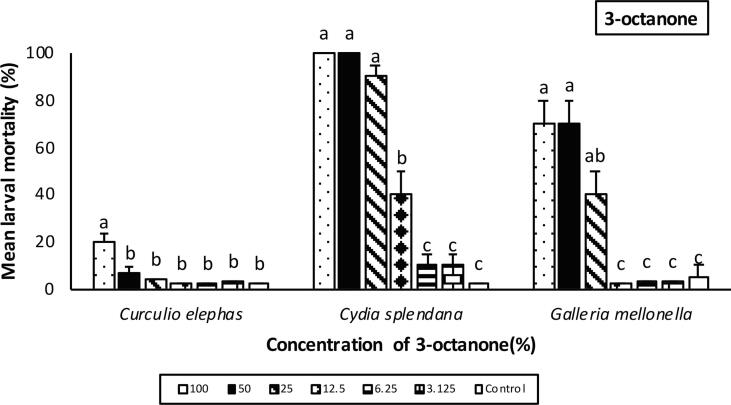
Mean percentage mortality of insect larvae (Curculio elephas, Cydia splendana, Galleria mellonella) exposed to 3-octanone after 48 hr. Error bars represent standard error. Lower case letters above error bars represent Tukey’s homogenous subset groups, indicating statistcal similarities and differences (P < 0.05; Tukey’s test).